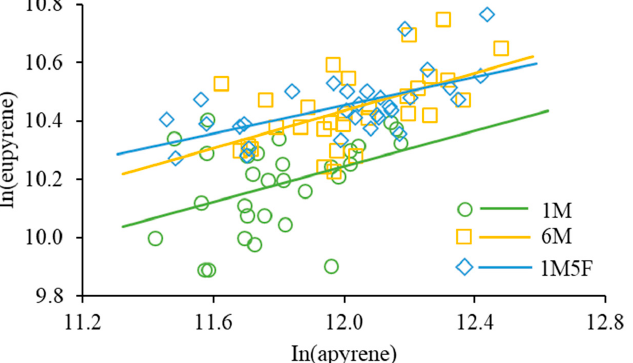
Figure 4. Relationship between the number of eupyrene and apyrene sperm produced. For 1M (one male), ln(eupyrene) = 6.58 + 0.31 × ln(apyrene), R 2 = 0.1594; for 6M (six males together), ln(eupyrene) = 6.59 + 0.32 × ln(apyrene), R 2 = 0.2990; and for 1M5F (one male and five females together), ln(eupyrene) = 7.54 + 0.24 × ln(apyrene), R 2 = 0.3729.